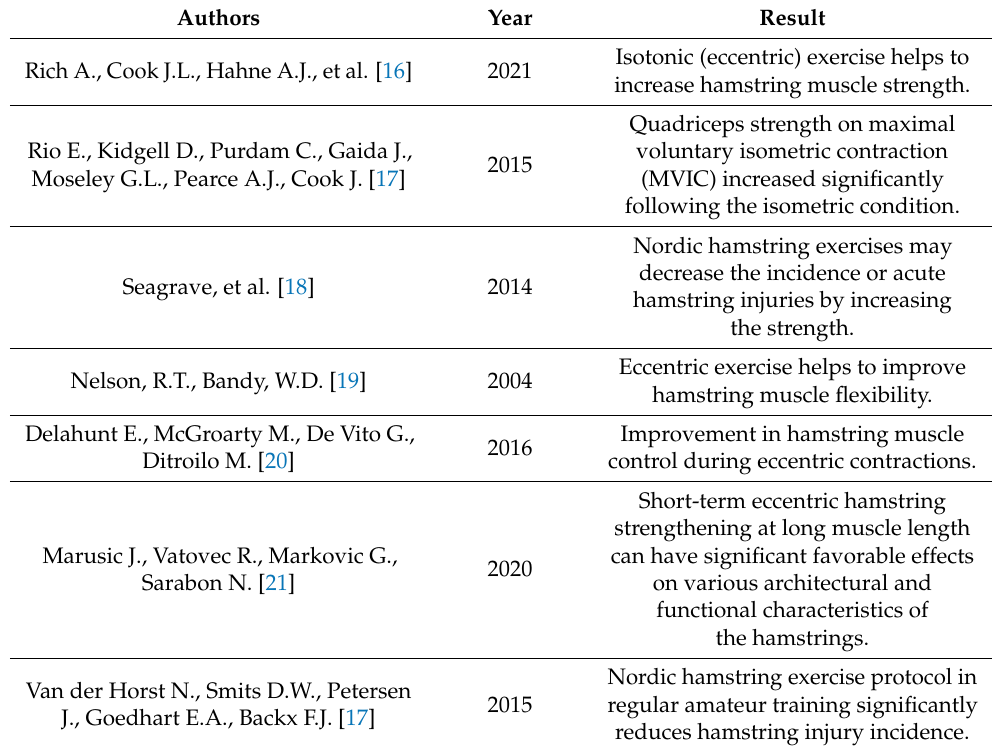
Table 1. Summary of related